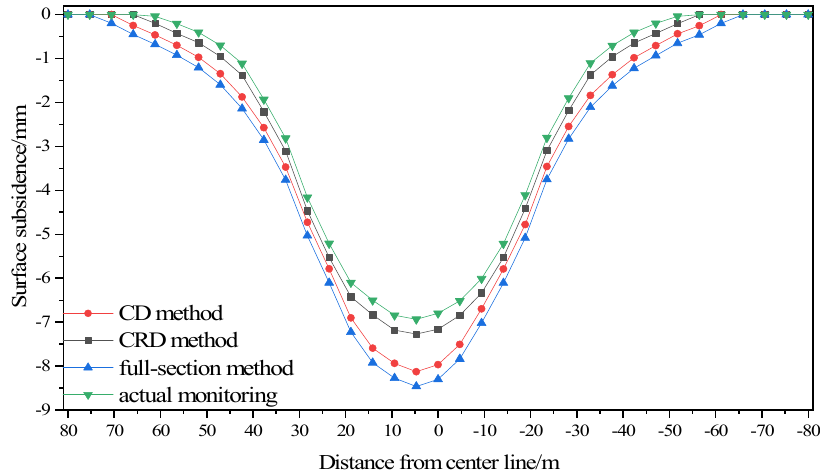
Figure 14. Surface surveying curve.